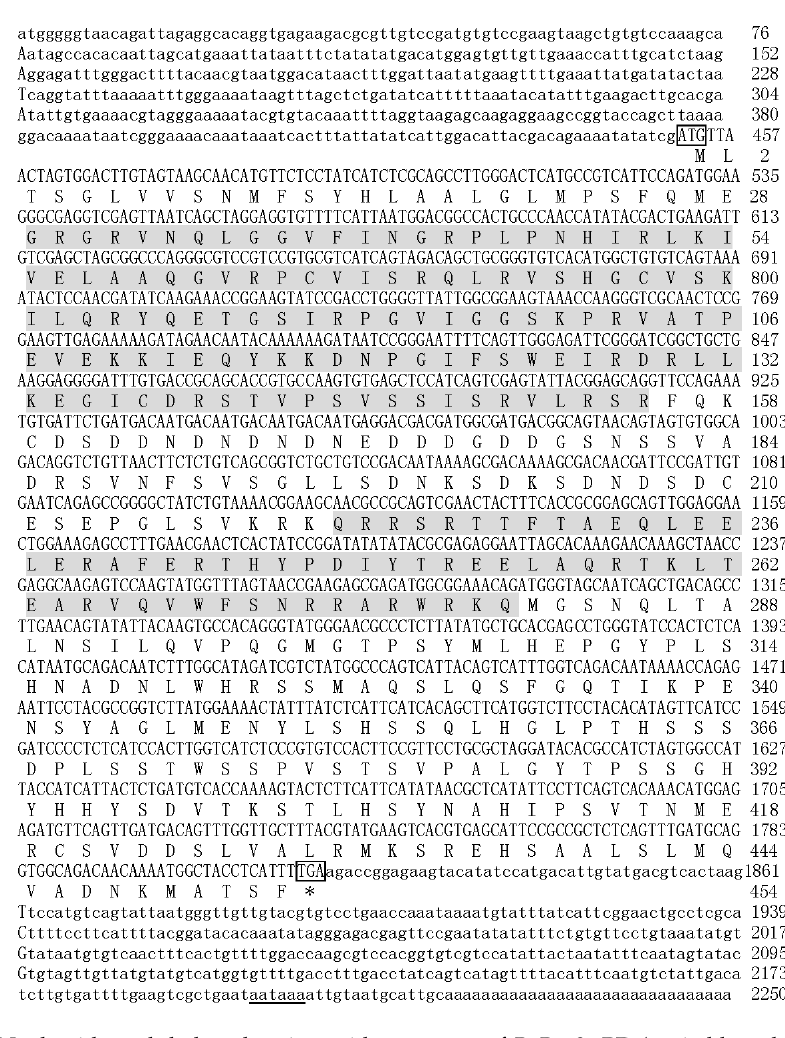
Figure 1. Nucleotide and deduced amino acid sequences of PpPax3. PD (paried box domain) and HD (homeodomain) were shown in grey boxes. The ORF (open reading frame) and deduced amino acid sequences were shown in uppercase. The 5 ′ - UTR (untranslated region) and 3’-UTR were shown in lowercase. The initiation codon (ATG) and the stop codon (TGA) were boxed. The putative polyadenylation signal (aataaa) was underlined.